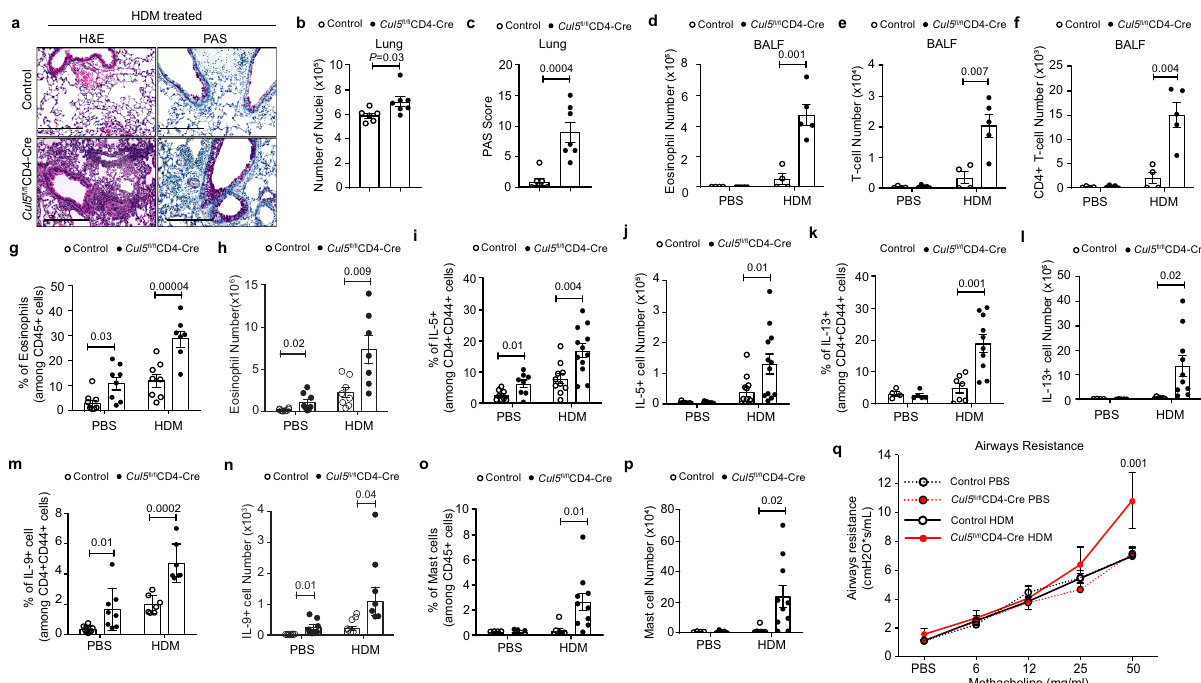
Fig. 3 Cul5 fl / fl CD4-Cre mice develop Th9-associated lung remodeling and airways hyperresponsiveness after allergen challenge. 8 – 10 week old control and Cul5 fl / fl CD4-Cre mice were treated with HDM or PBS. Hematoxylin and Eosin (H&E) and Periodic Acid-Schiff (PAS) stain of lungs. Representative image ( a ) of H&E and PAS stain (combined data shown in panels b and c ). Bar graph ( b ) showing the number of nuclei enumerated by Aperio ImageScope software in 100 mm 2 area. n = 6 control, n = 7 Cul5 fl / fl CD4-Cre , examined in two independent experiments. Bar graph showing PAS score ( c ) in lungs. n =